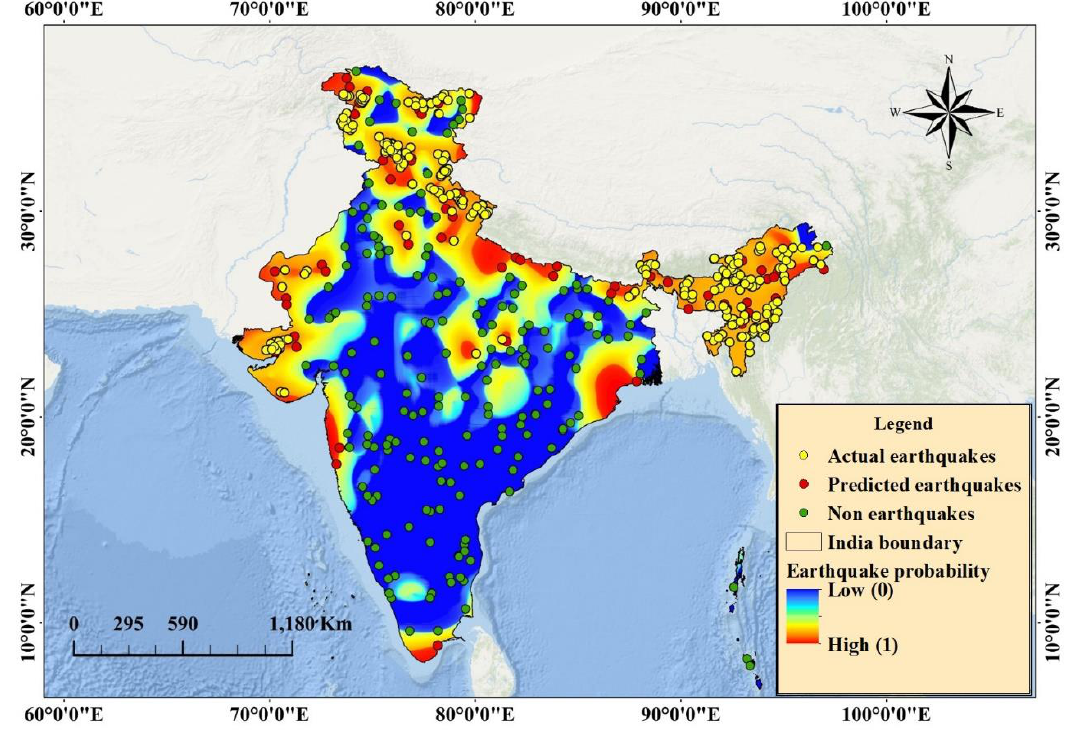
Figure 7. Earthquake probability map.